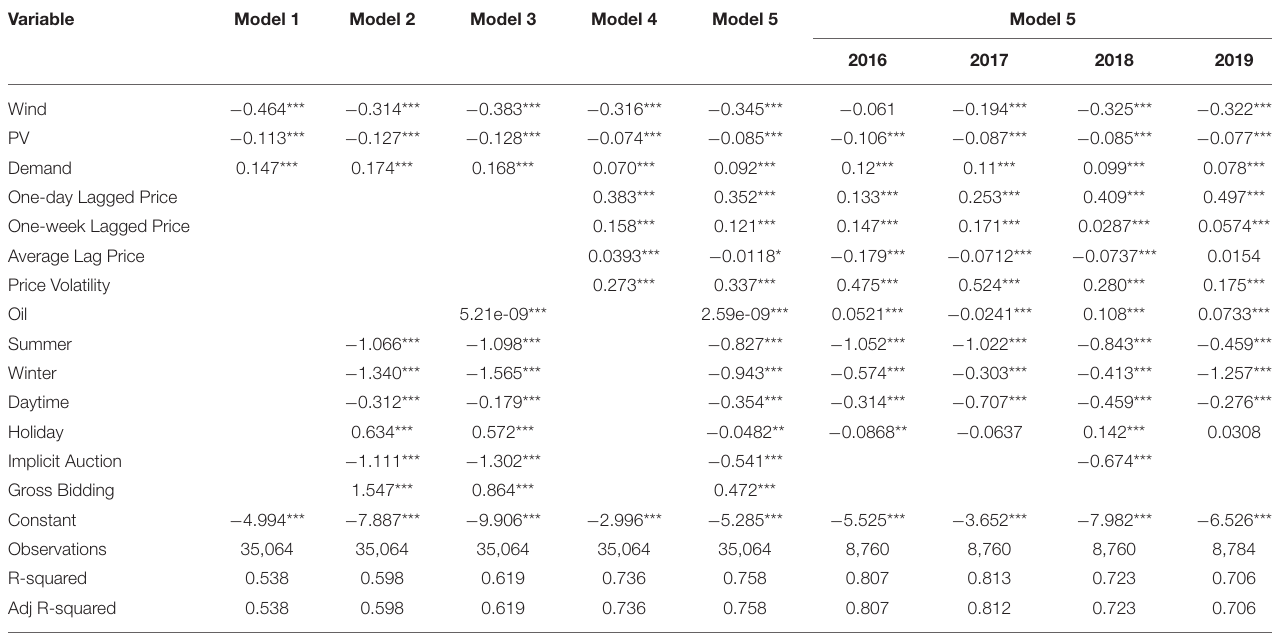
TABLE 2 | The results of the OLS regression analysis of system prices. Variable